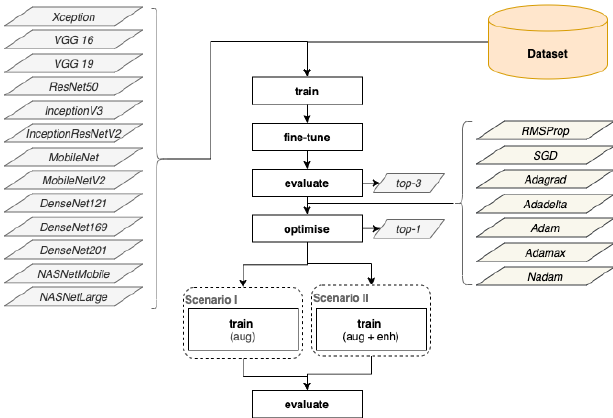
Figure 6. System for the detection of Diabetic Eye